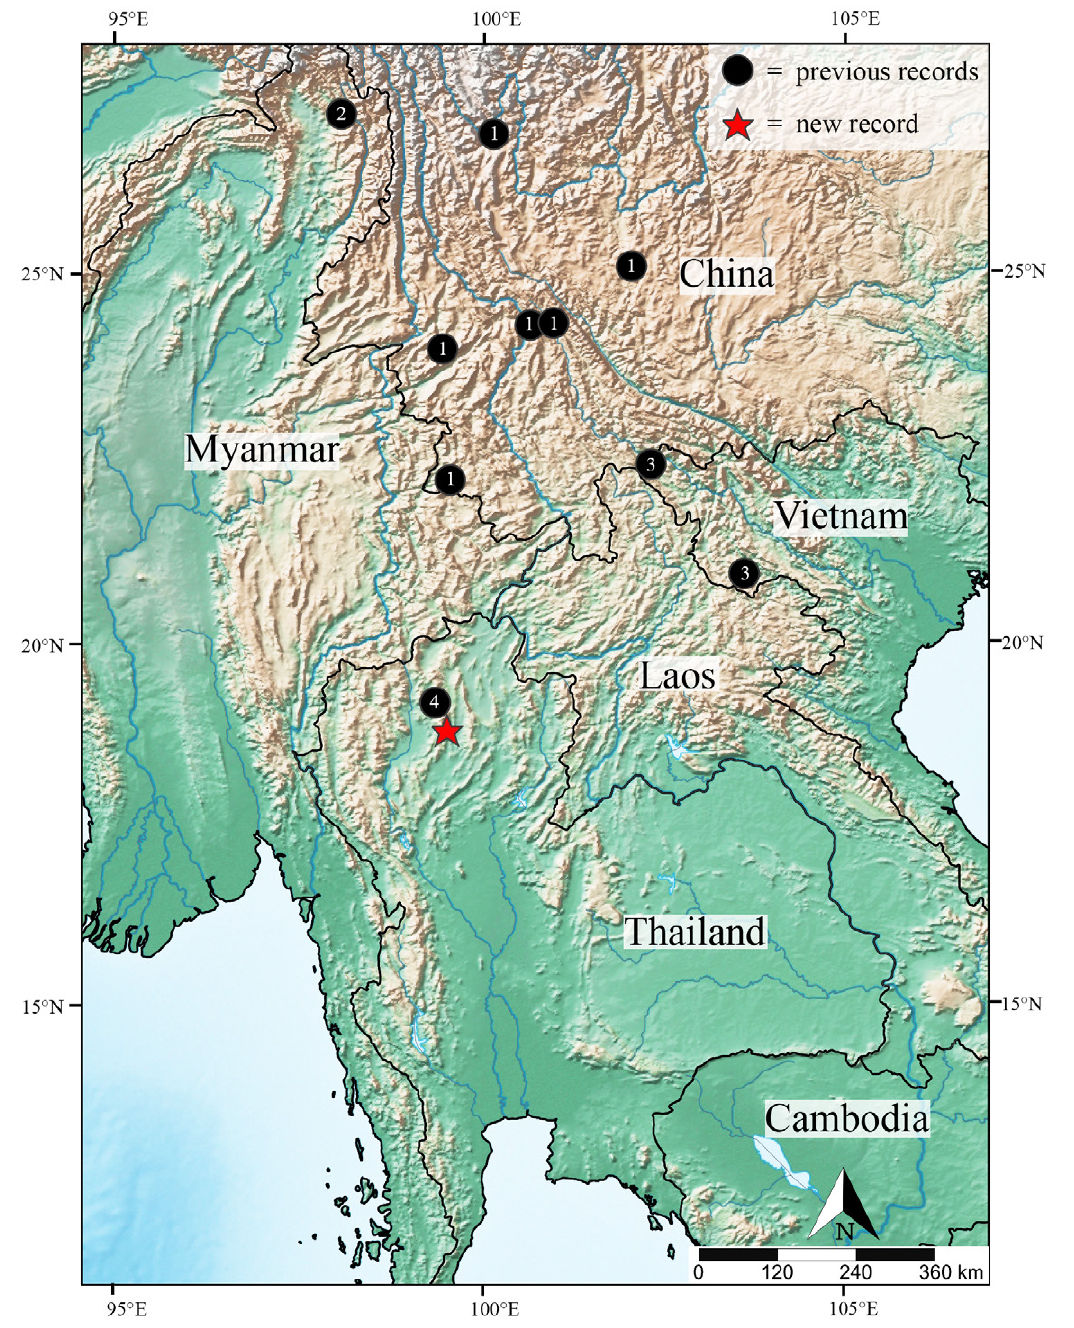
Figure 2. Geographic distribution of Trimerodytes yunnanensis . A red star indicates the new record of T. yunnanensis from Mueang Pan District, Lampang province, Thailand, and black circles indicate previous records of T. yunnanensis from (1) China (Rao and Yang 1998), (2) Myanmar (Wogan et al. 2008; Ren et al. 2019), (3) Vietnam (Le et al. 2015) and (4) Thailand (Pauwels et al.